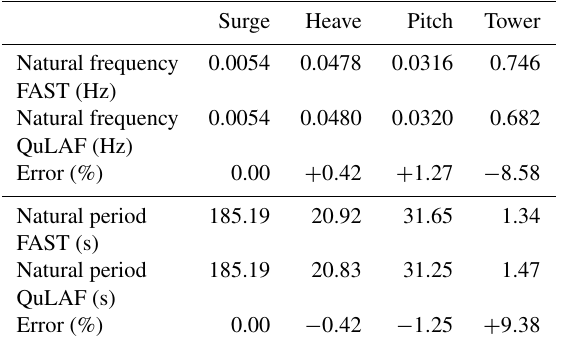
Table 3. Natural frequencies and periods obtained in FAST and